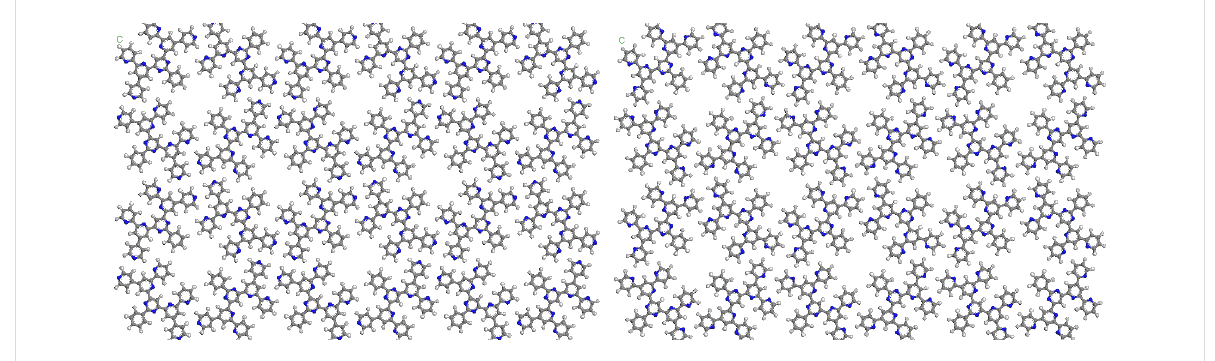
Figure 5: Adsorbate structures of 2,4'-BTP ( 2 ) (left) and 2,2'-BTP ( 5 ) (right) in the square symmetric structure, optimized with the Compass [32] force field.